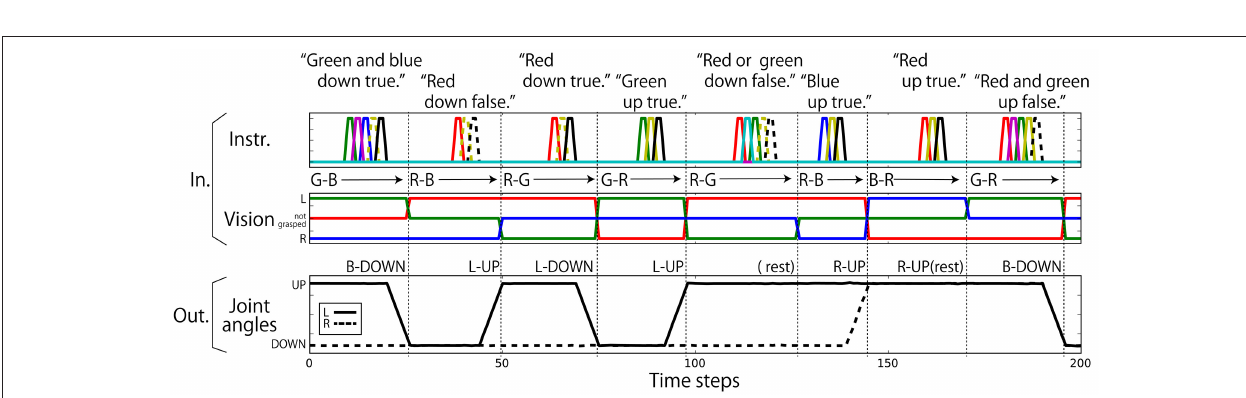
Frontiers in Neurorobotics |